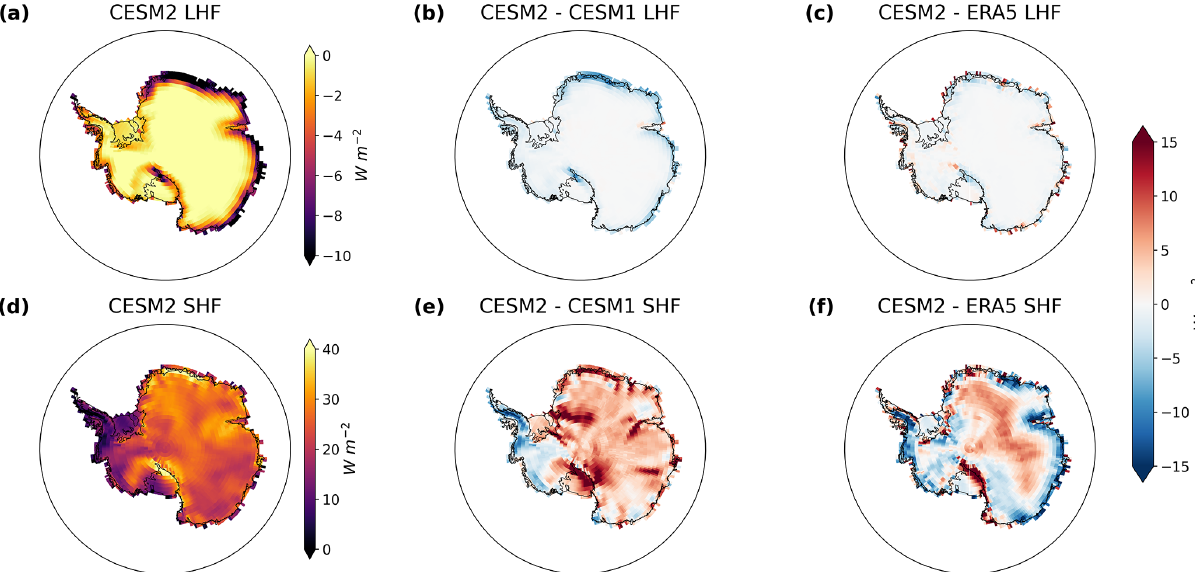
Figure A3. Comparison of turbulent fluxes between CESM2 (1979–2015), CESM1 (1979–2005), and ERA5 (1979–2015). (a) CESM2 average annual latent heat flux (LHF). (b) CESM2–CESM1 average annual LHF. (c) CESM–ERA5 average annual LHF. (d) CESM2 average annual sensible heat flux (SHF). (e) CESM2–CESM1 average annual SHF. (f) CESM2–ERA5 average annual SHF. Positive values indicate a downward net energy flux (into the ice